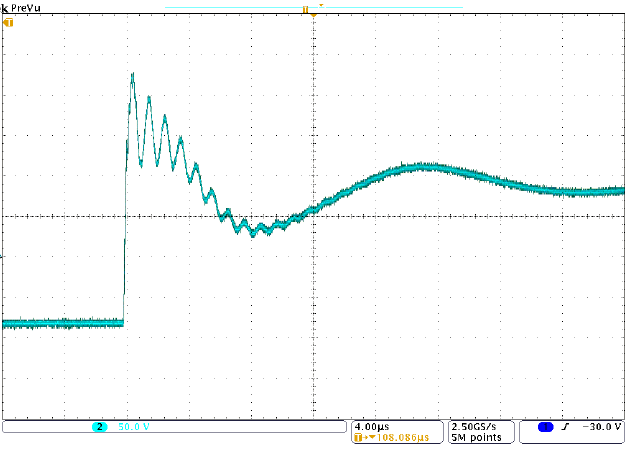
Figure 1. A phase voltage measured on the motor terminals (motor was connected to the inverter through a cable of 2.5 m in length).